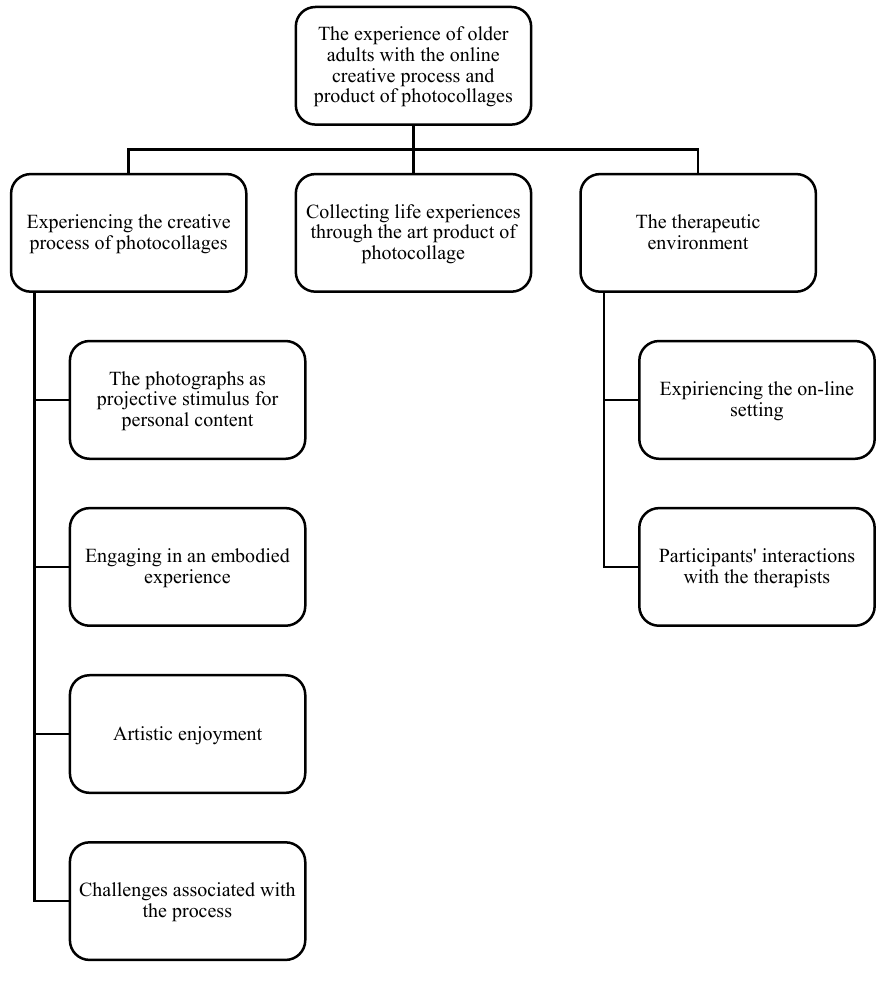
Figure 1. The thematic map .